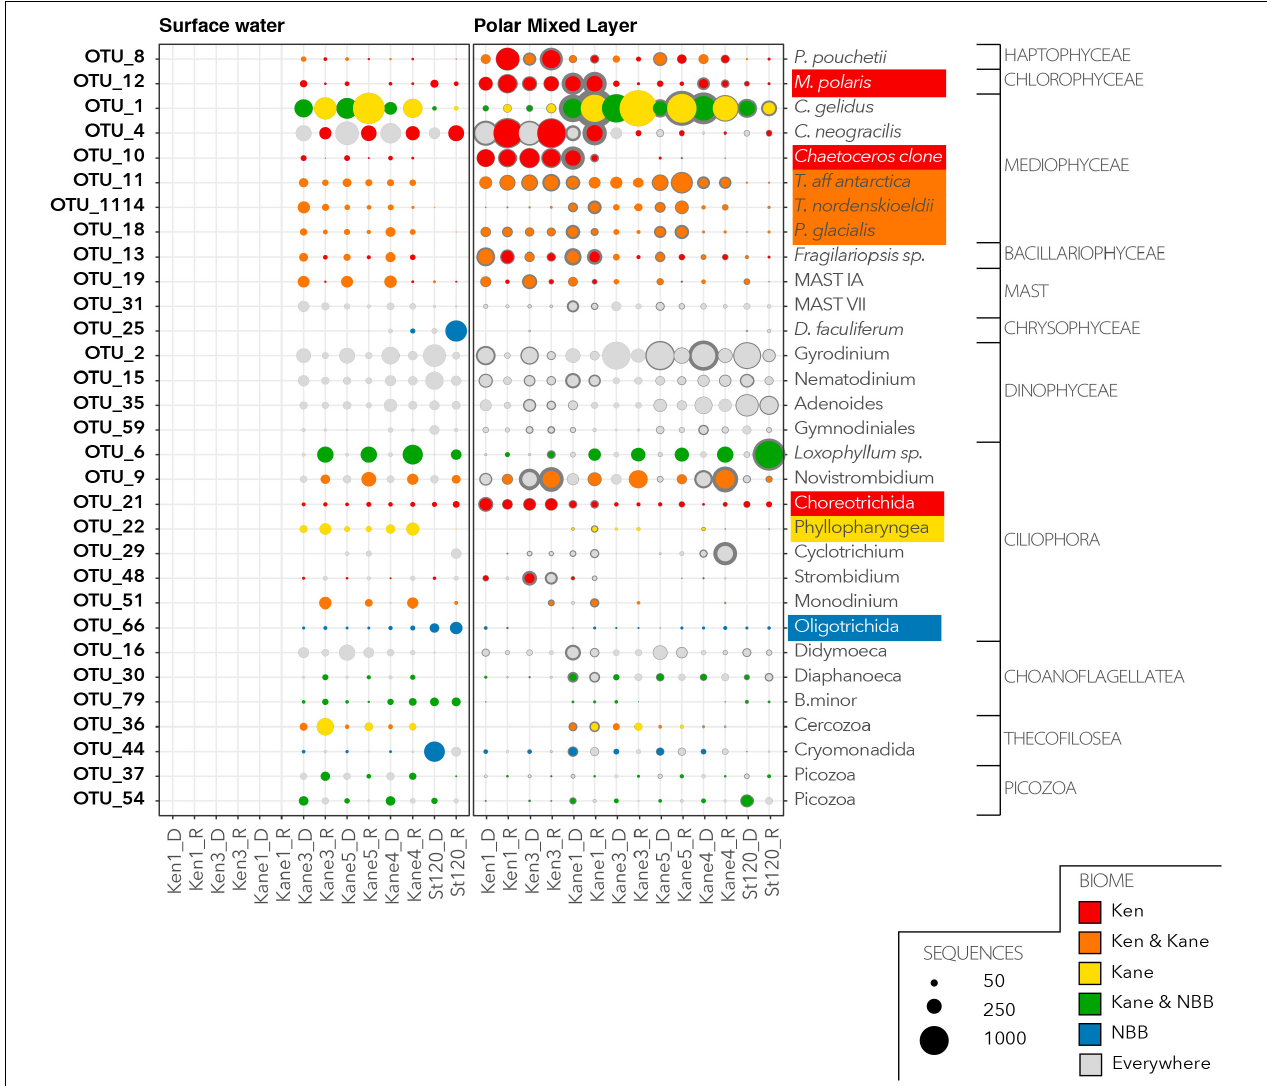
FIGURE 6 | Characteristic OTUs from the euphotic zone communities. Bubble plots of the mean relative abundance of the dominant OTUs in the euphotic zone, separated by water mass categories given in Figure 2 . For each dominant OTU the bubble size is the mean (light gray or colored dot) and confidence interval (dark gray exterior circle) for the number of OTU reads from each of the rDNA and rRNA communities. Based on the results of the CLAM test, the bubbles with primary colors indicate specificity to a region (red for Kennedy Channel; yellow for Kane Basin; and blue for Northern Baffin Bay). The bubbles in a secondary color are a mix of the contributing primary colors and show OTUs that are considered characteristic of two regions. If an OTU was characteristic of a region in both rDNA and rRNA they were considered representative of the region and the taxonomic assignment is shaded by the color code for the region.